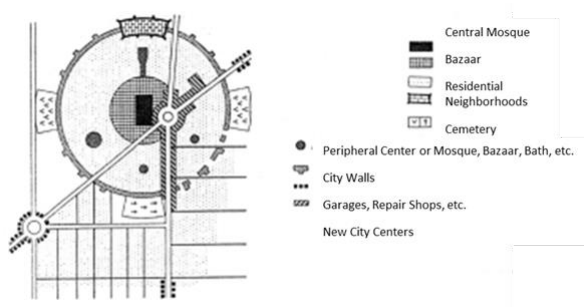
Figure 3 .Islamic City Model (Source: Ehlers 1991, Cited by Shafaqi